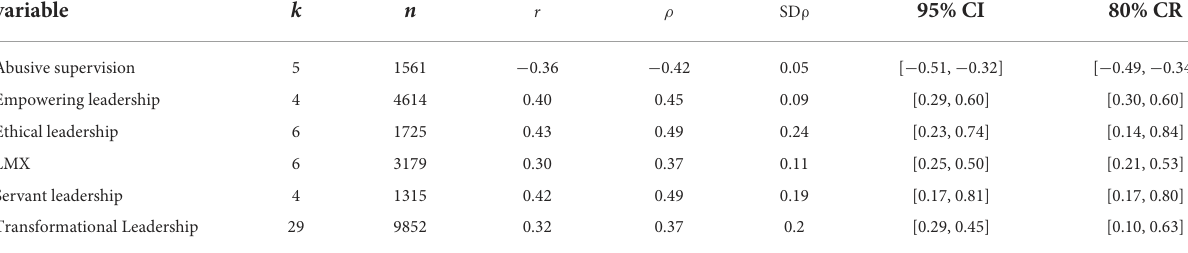
TABLE 3 Bivariate relationships between leadership and intrinsic